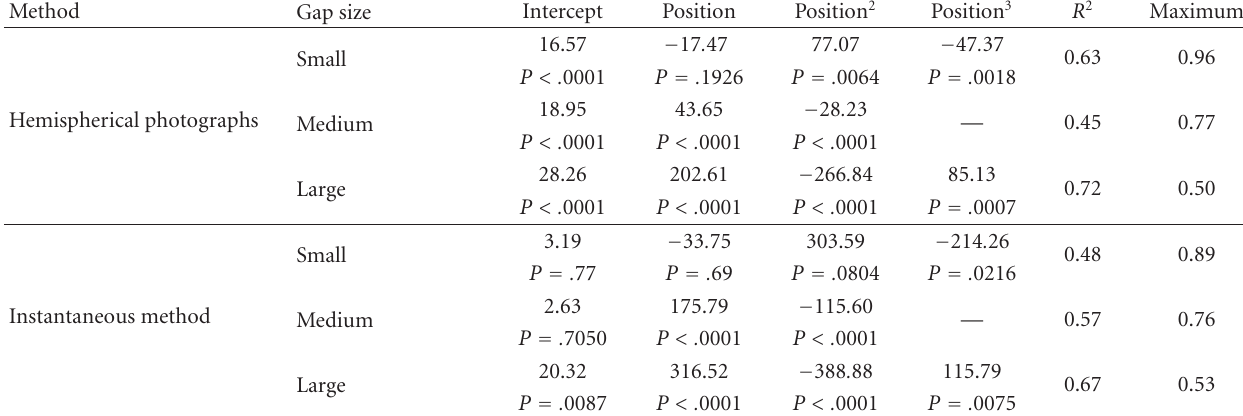
Table 2: Results of the polynomial models for both methods (hemispherical photographs and instantaneous measurements) and for each gap size (small, medium, and large). For each model, the estimation of coe ffi cients and their relative probability, R 2 , and the position of maximum light are